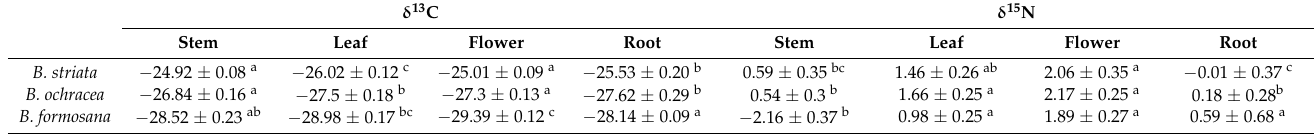
Table 3. Comparison of δ 13 C and δ 15 N values (mean ± SE) among different organs for each Bletilla species. δ 13 C δ 15